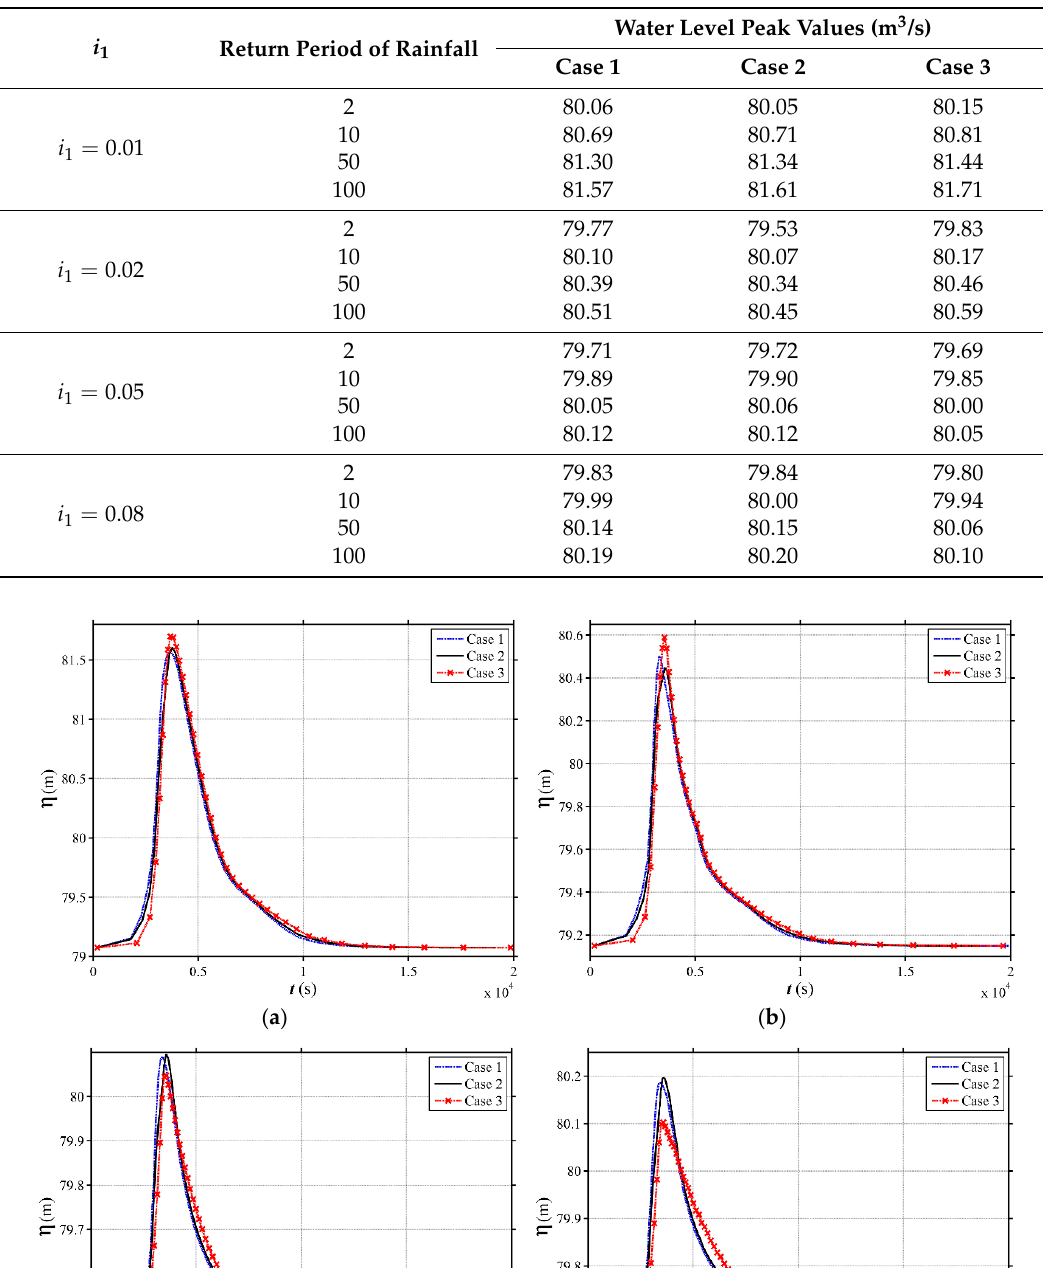
Table 3. Comparison water level peak values for different land use scenarios.